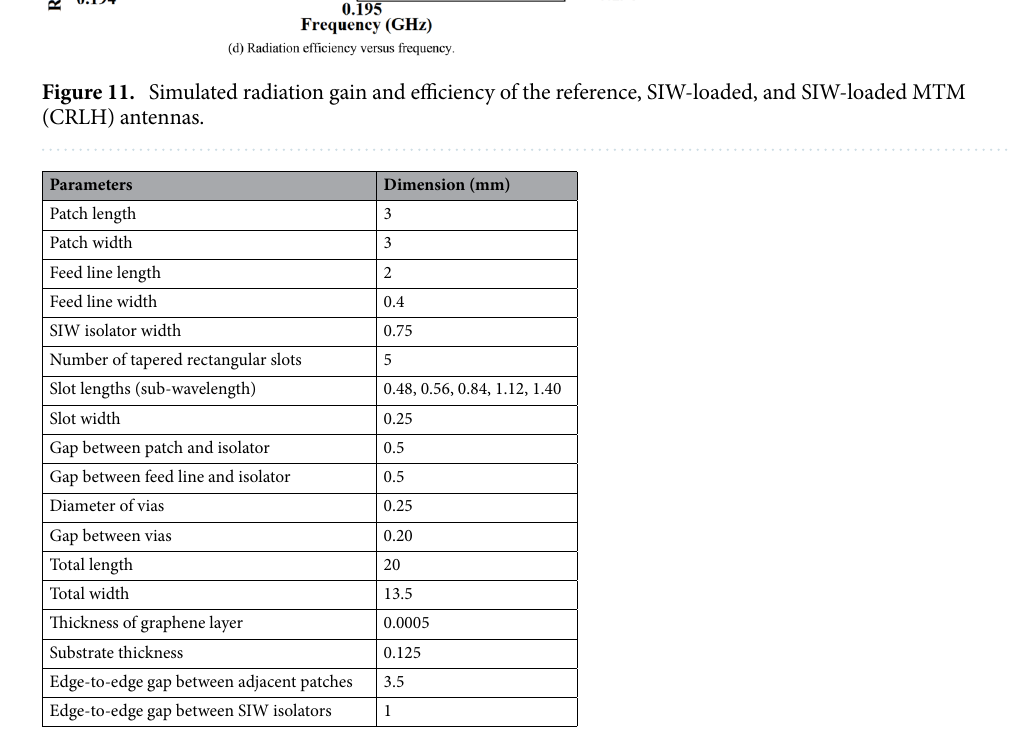
Table 2. Structural dimensions of the